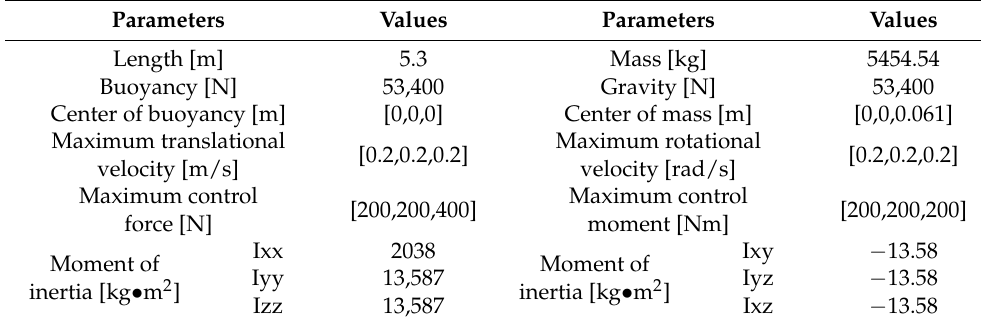
Table 1. Physical parameters of the